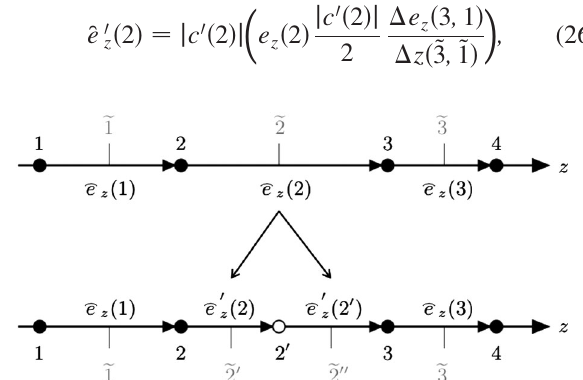
FIG. 5. Interpolation of electric grid voltages oriented perpen- ð 2 Þ is split dicularly to the refinement. The coarse grid voltage ̑ e z ð 2 Þ and ̑ e 0 ð 2 0 Þ such that the total voltage into the two voltages ̑ e 0 z z in between nodes 2 and 3 is preserved [cf. Eq. (25)]. In order to ð 2 Þ and ̑ e 0 ð 2 0 Þ , the voltage gradient along the assign values to ̑ e 0 z z ð 1 Þ and ̑ e ð 3 Þ [cf. Eqs. (26) and axis is evaluated using ̑ e z z